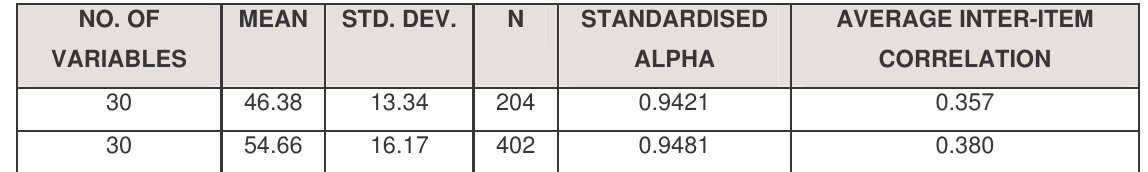
Table 3: Reliability Values – Split Sample NO. OF STD.